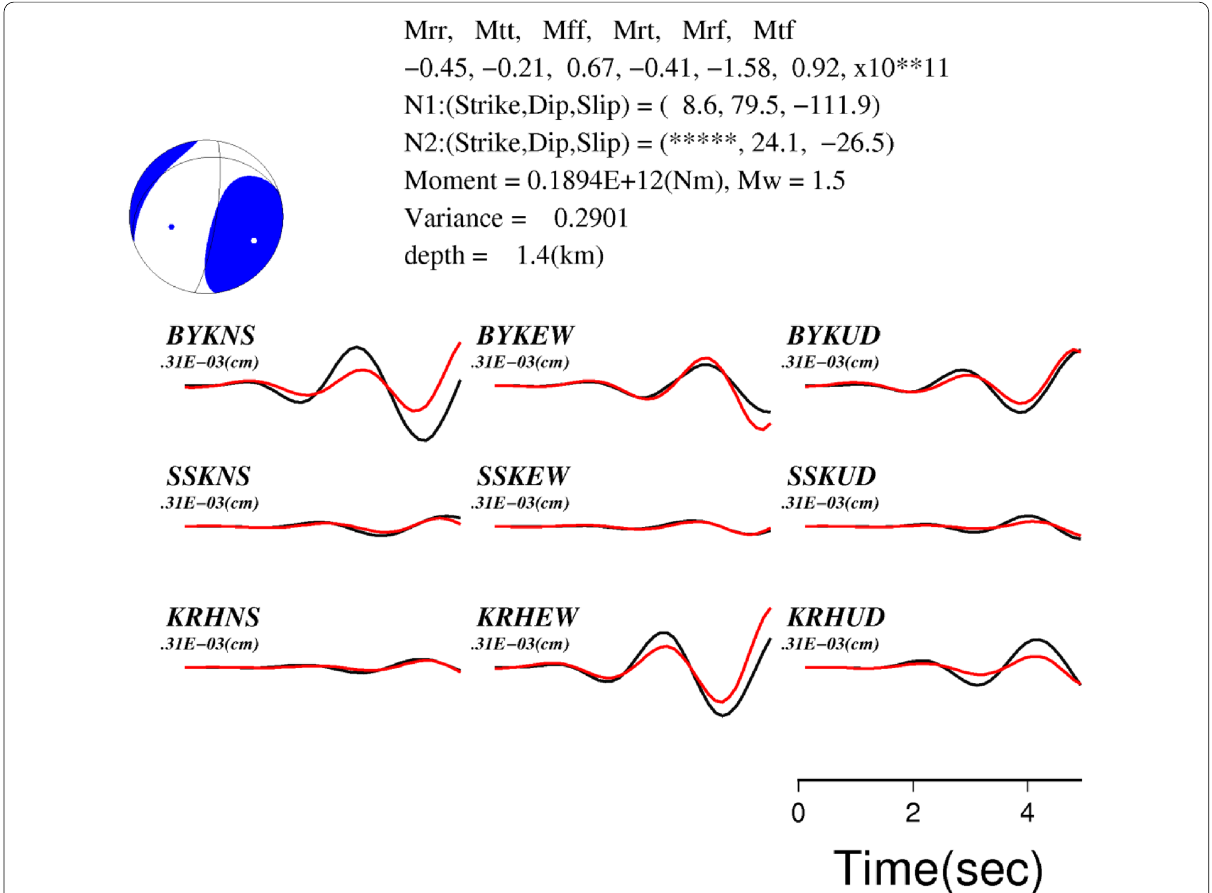
Fig. 4 The original output of the focal mechanism process of the smallest event that occurred on 26 February 2011 at 15:24 (event ID: 1102261524). The black and red lines are observational and synthetic waveforms,